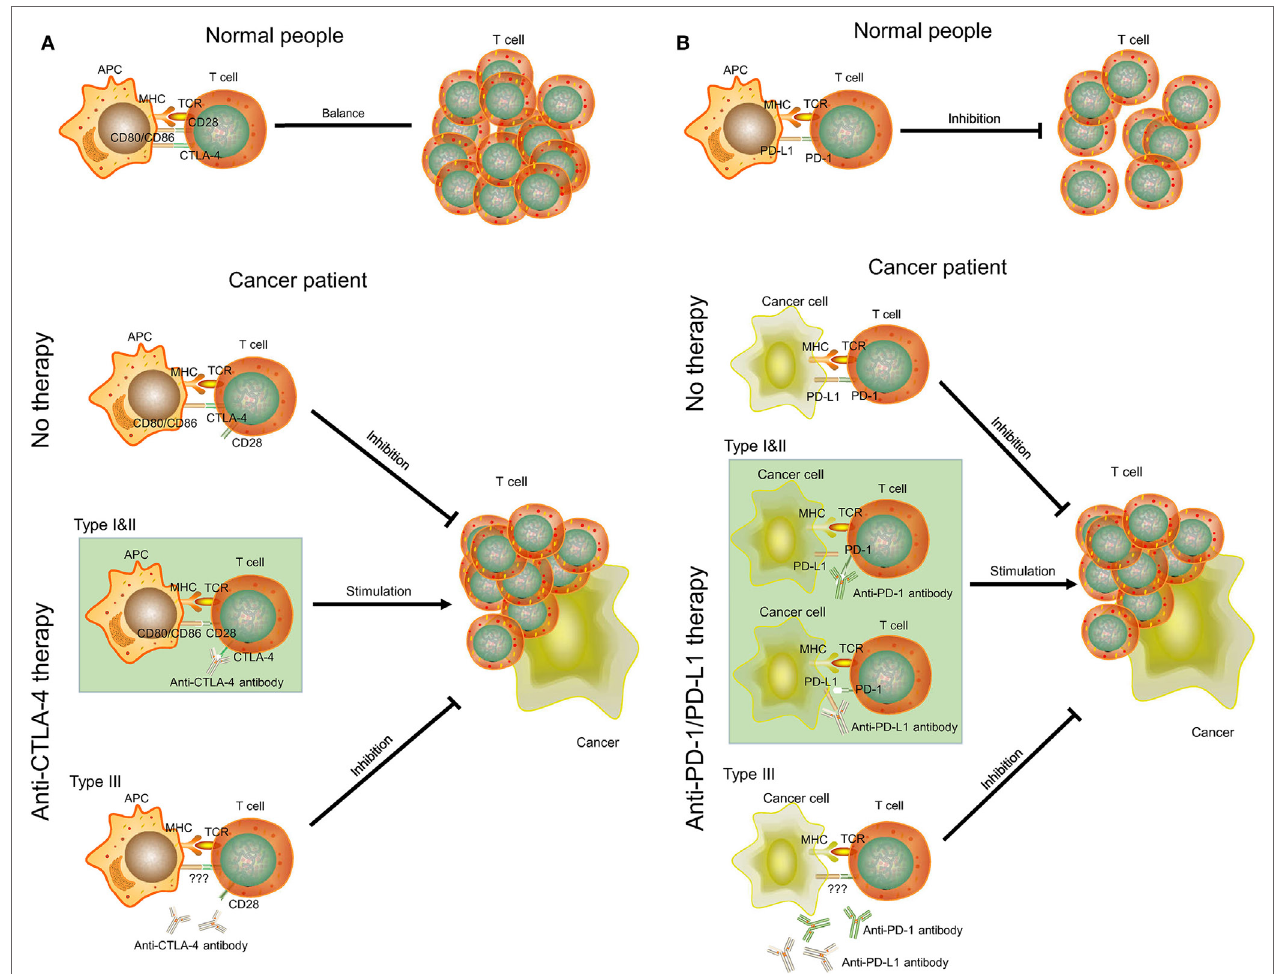
FigUre 5 | The mechanisms of CTLA-4 , PD-1 / PD-L1 , anti-CTLA-4, and anti-PD-1/PD-L1 therapy in cancer. (a) CTLA-4 and anti-CTLA-4 therapy. (b) PD-1 / PD-L1 and anti-PD-1/PD-L1 therapy. APC, antigen-presenting cell; MHC, major histocompatibility complex; TCR, T-cell